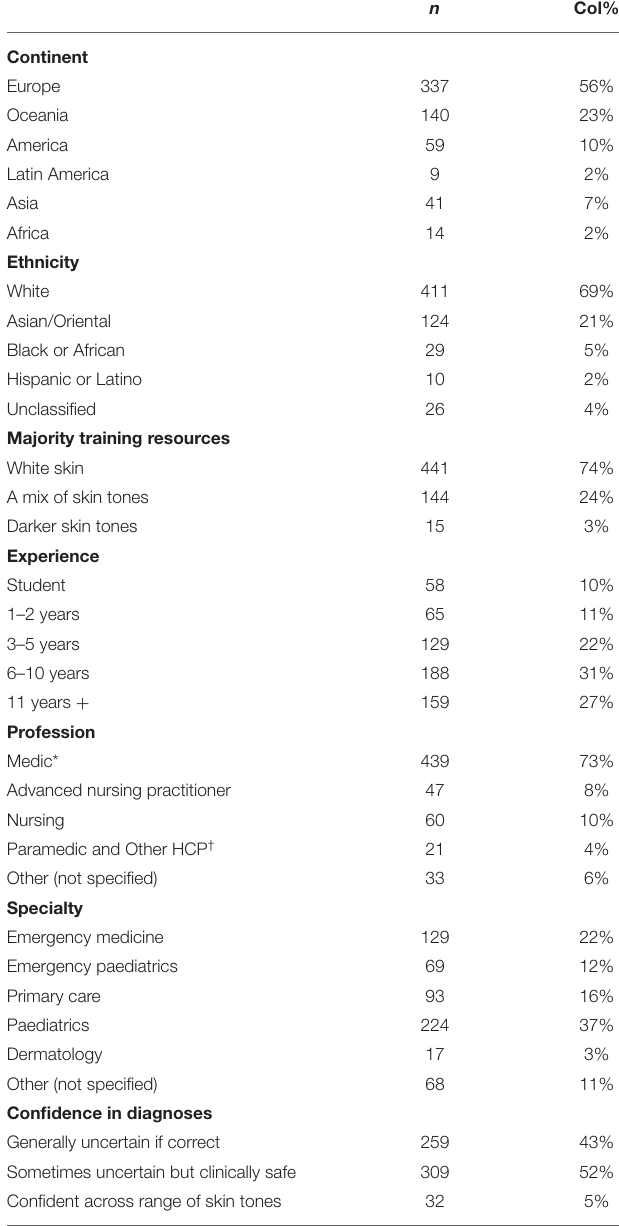
TABLE 1 | Characteristics of the survey respondents ( n =